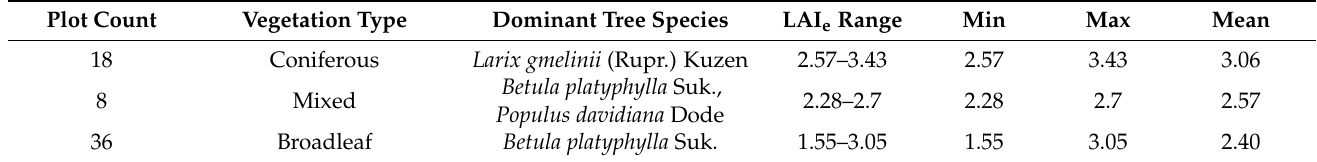
Table 1. Plot-level